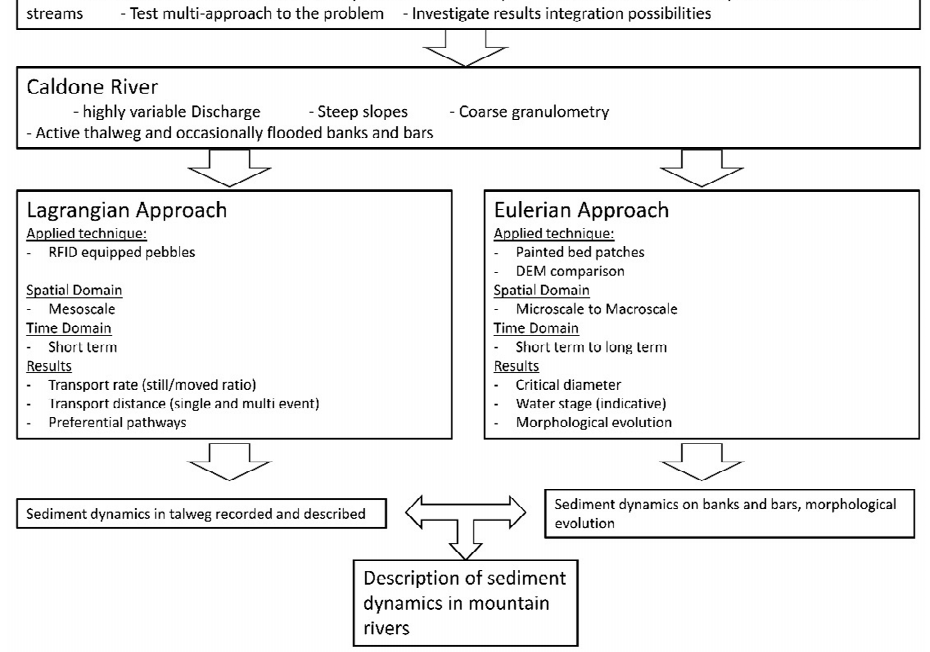
Figure 1. Flow chart of the present work. Main features of applied methods are highlighted along with the results obtained.